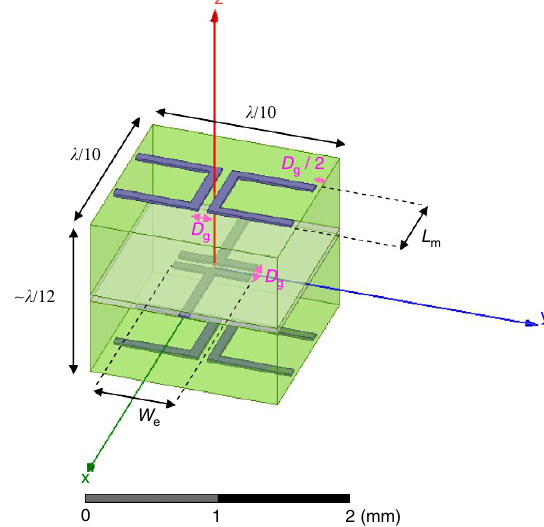
Figure 4 | Spider unit cells. Physical configuration of the meta-atoms used for implementing the HMS at a frequency of f ¼ 20GHz ( l E 15mm). The electric response is controlled by the capacitor width W e of the electric dipole, while the magnetic response is determined by the magnetic dipole arm length L m . The gap size (magenta) and copper trace width are fixed to D g ¼ 3mil E 76 m m to comply with standard printed-circuit board fabrication techniques.